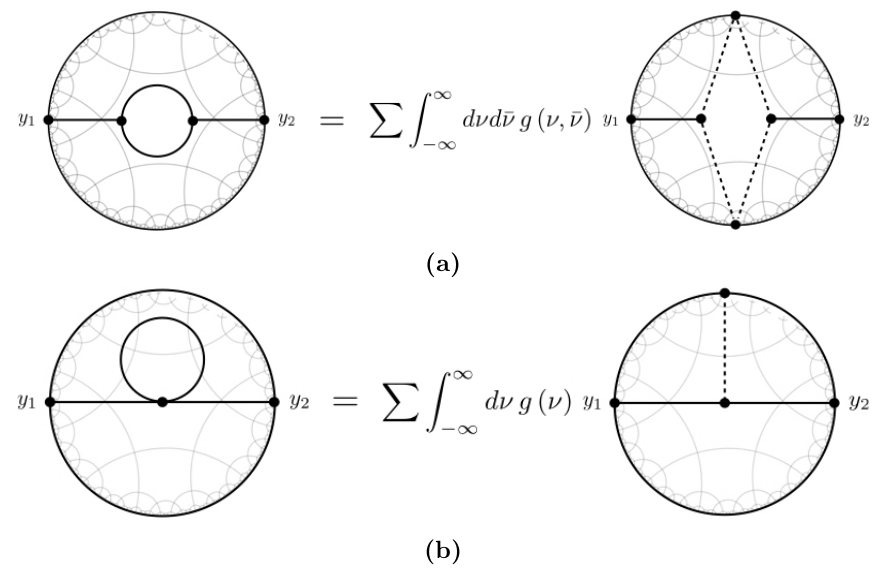
Figure 1. Using the split representation of bulk-to-bulk propagators, 2pt Witten diagrams at one-loop may be expressed in terms of tree-level three-point Witten